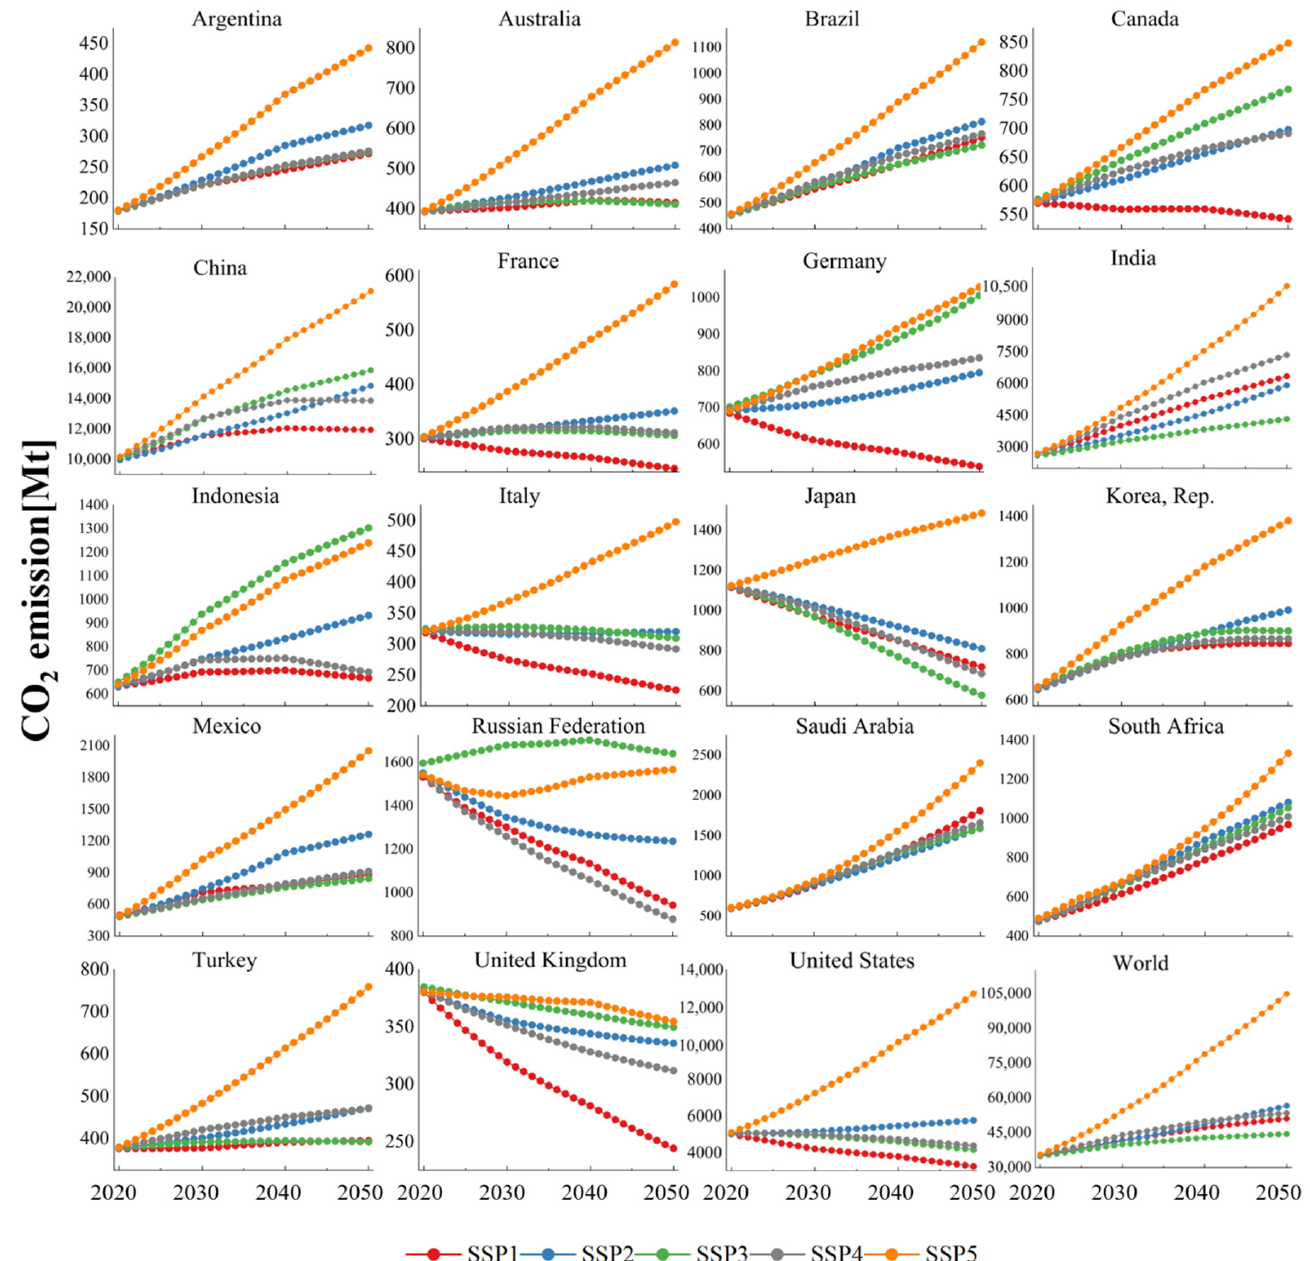
Figure 2. CO 2 emission paths during 2020–2050 in baseline scenarios of SSP.